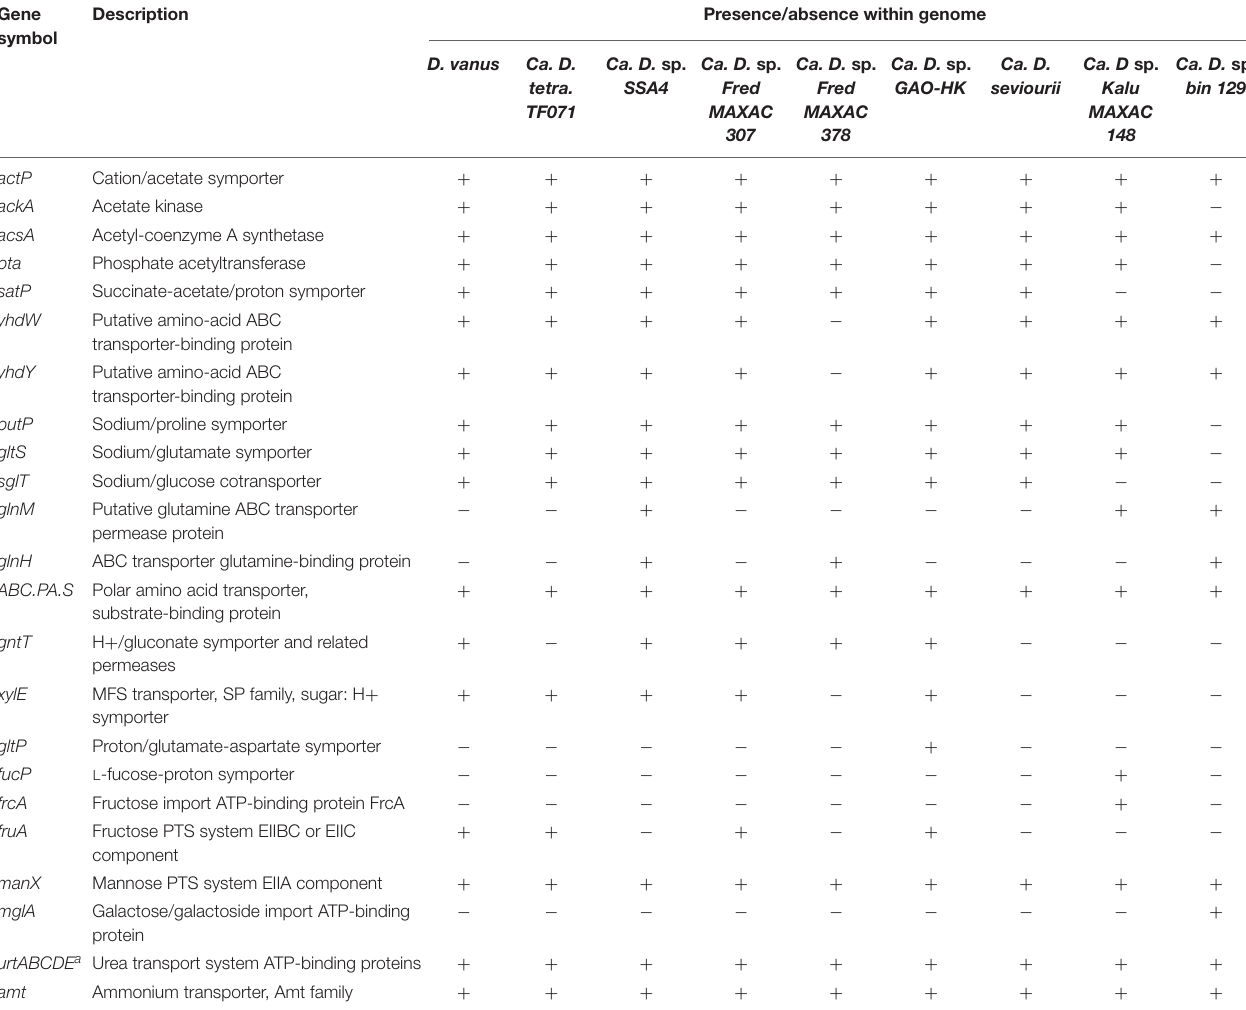
TABLE 2 | Selected genes related to substrate and amino acid uptake present in genomes from members of the genus Defluviicoccus. Gene symbol